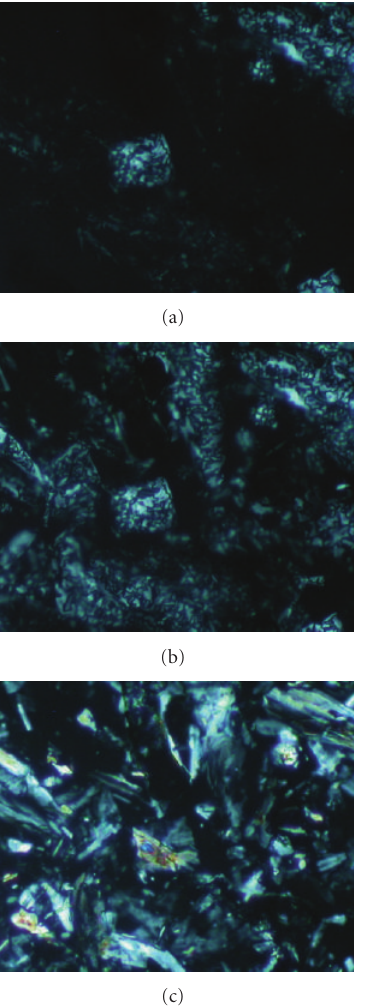
Figure 18: Polarized optical micrographs of cholesteryl benzoate dispersed in UV15 taken during cooling from the isotropic phase at (a) 100.5 ◦ C, (b) 85.4 ◦ C, and (c) 25 ◦